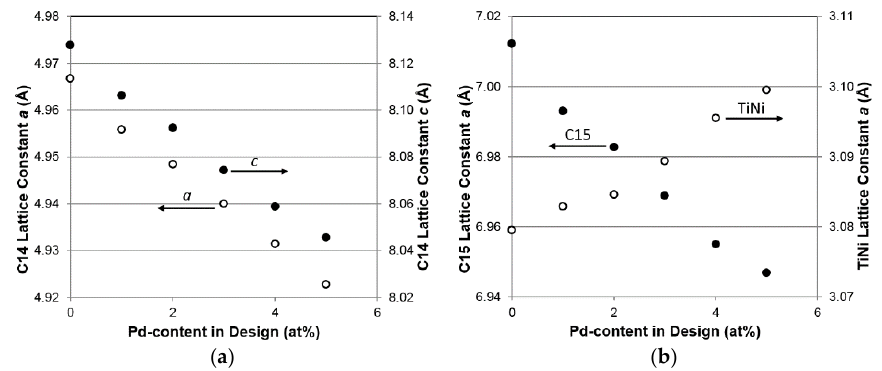
Figure 2. Evolution of the lattice constants of the ( a ) C14 and ( b ) C15 and TiNi phases with increasing Pd-content in design.